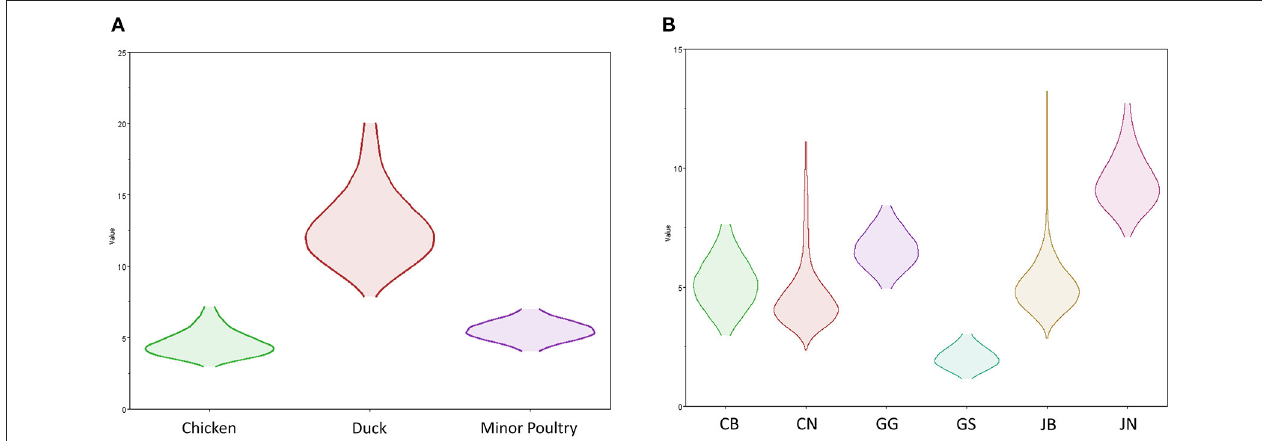
FIGURE 7 | Transmission dynamics between host species and geographical region of H5N8 high pathogenicity avian influenza viruses isolated in South Korea during 2014–2016 (Markov rewards). (A) The host species and (B) regions were defined as discrete states. Markov rewards were calculated for each posterior tree using a non-reversible continuous-time Markov chain